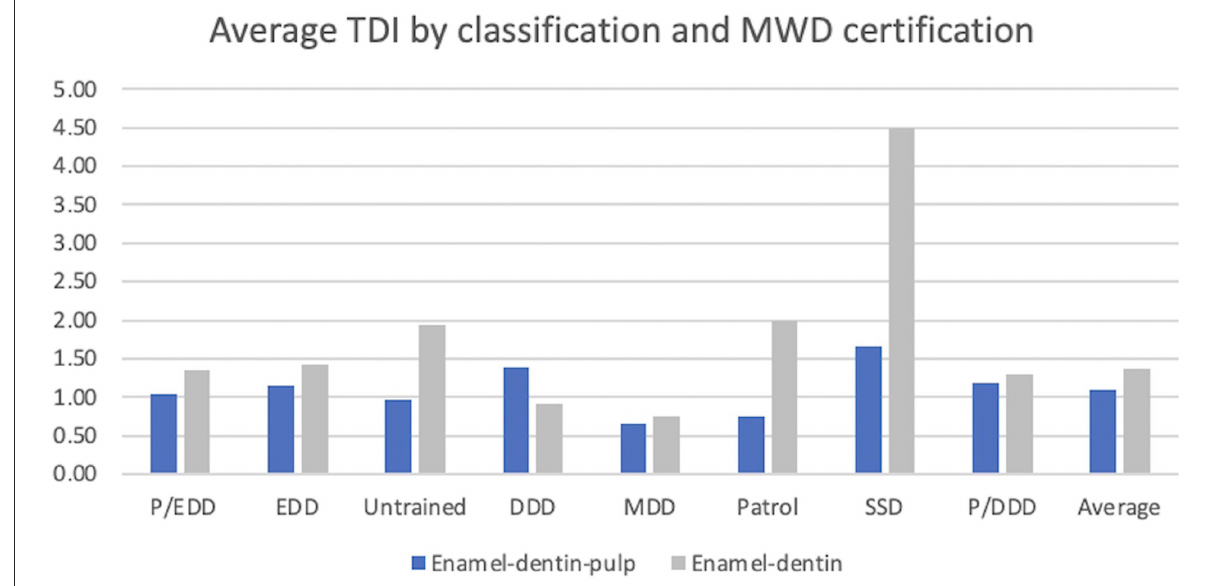
FIGURE6 Graphical description of TDI and MWD certification. P/EDD (Patrol/Explosive Detection Dog), EDD (Explosive Detection Dog), Untrained (not certified), DDD (Drug Detection Dog), MDD (Mine Detection Dog), Patrol, SSD (Specialized Search Dog), P/DDD (Patrol/Drug Detection Dog). There was no statistical significance between MWD certification and enamel-dentin-pulp fractures.